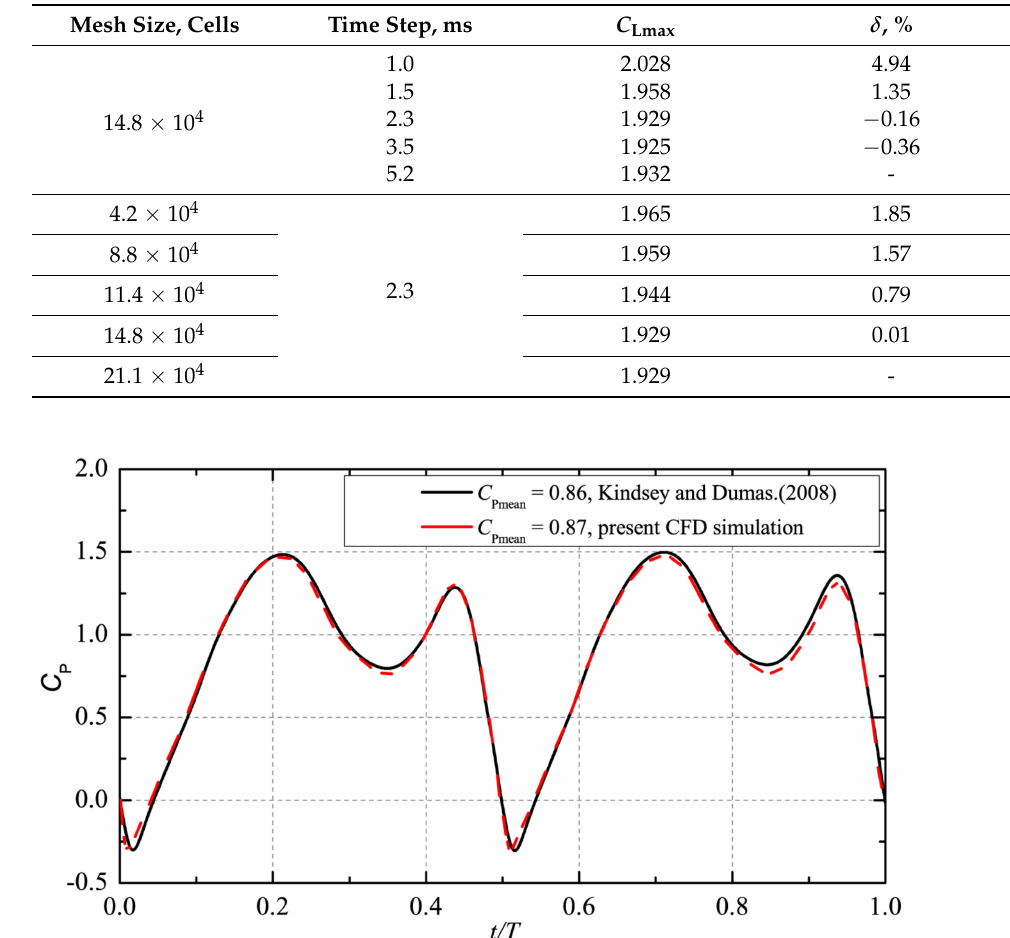
Figure 4. Variations of C L in one cycle for five sets of mesh and time step resolutions. ( a ) Mesh dependency. ( b ) Time step dependency. Table 1. Deviations of maximum lift coefficient for different mesh and time step configurations.